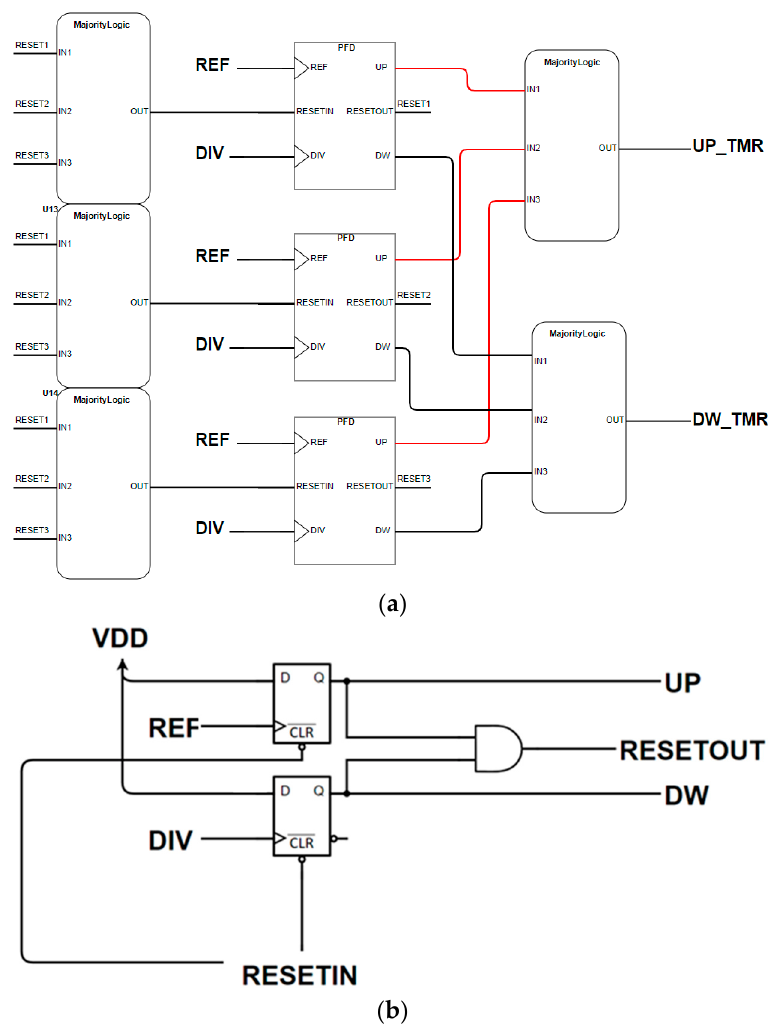
Figure 13. Triple modular redundant PFD architecture in ( a ) and simple PFD architecture in ( b ).